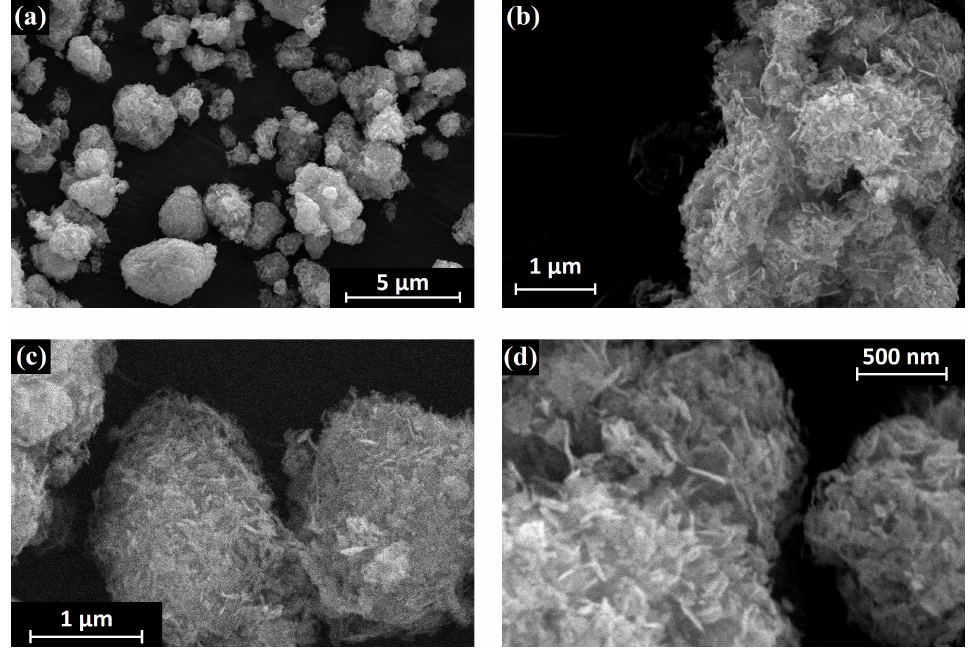
Figure 5. SEM images of synthesized nanocrystalline ZnO powder at different magnifications: ( a )—micrometer-sized aggregates; ( b – d )—needle-shaped ZnO nanoparticles in